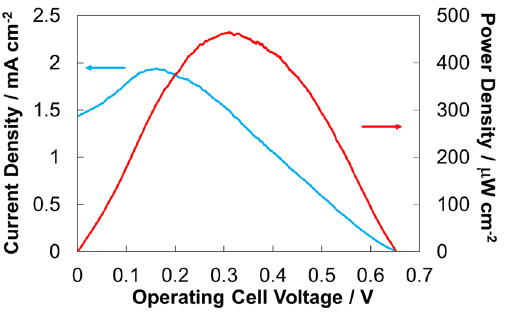
Figure 6. Electrochemically evaluating biofuel cells fabricated using MgOC inks with CMC and bilirubin as guides for BOD immobilization. Conditions: 1 M phosphate buffer, pH 7.0; 100 mM lactate; humidity 70%;